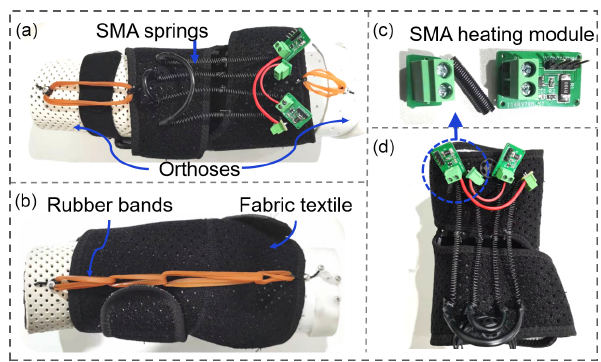
Figure 6. Experimental prototype of elbow exoskeleton. (a, b) Ex- perimental prototype. (c, d) SMA actuator and heating